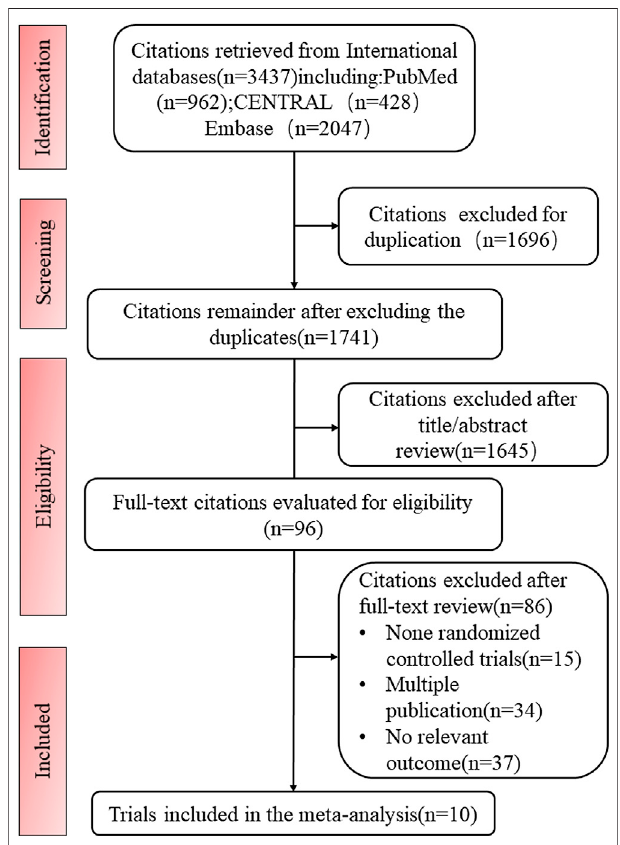
FIGURE 1 | PRISMA fl ow diagram of study selection